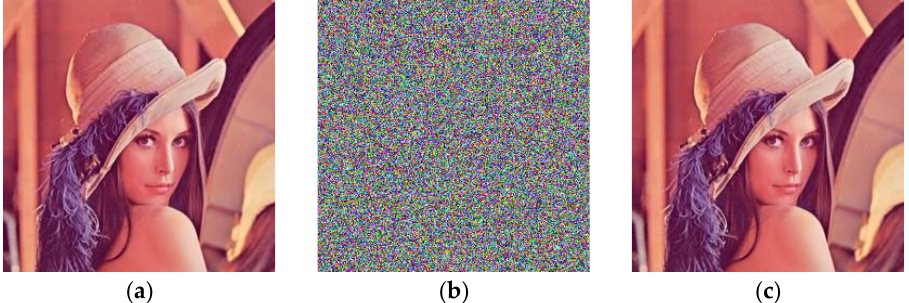
Figure 5. Lena encryption process. ( a ) Original image Lena; ( b ) encrypted image Lena; ( c ) decrypted image Lena.